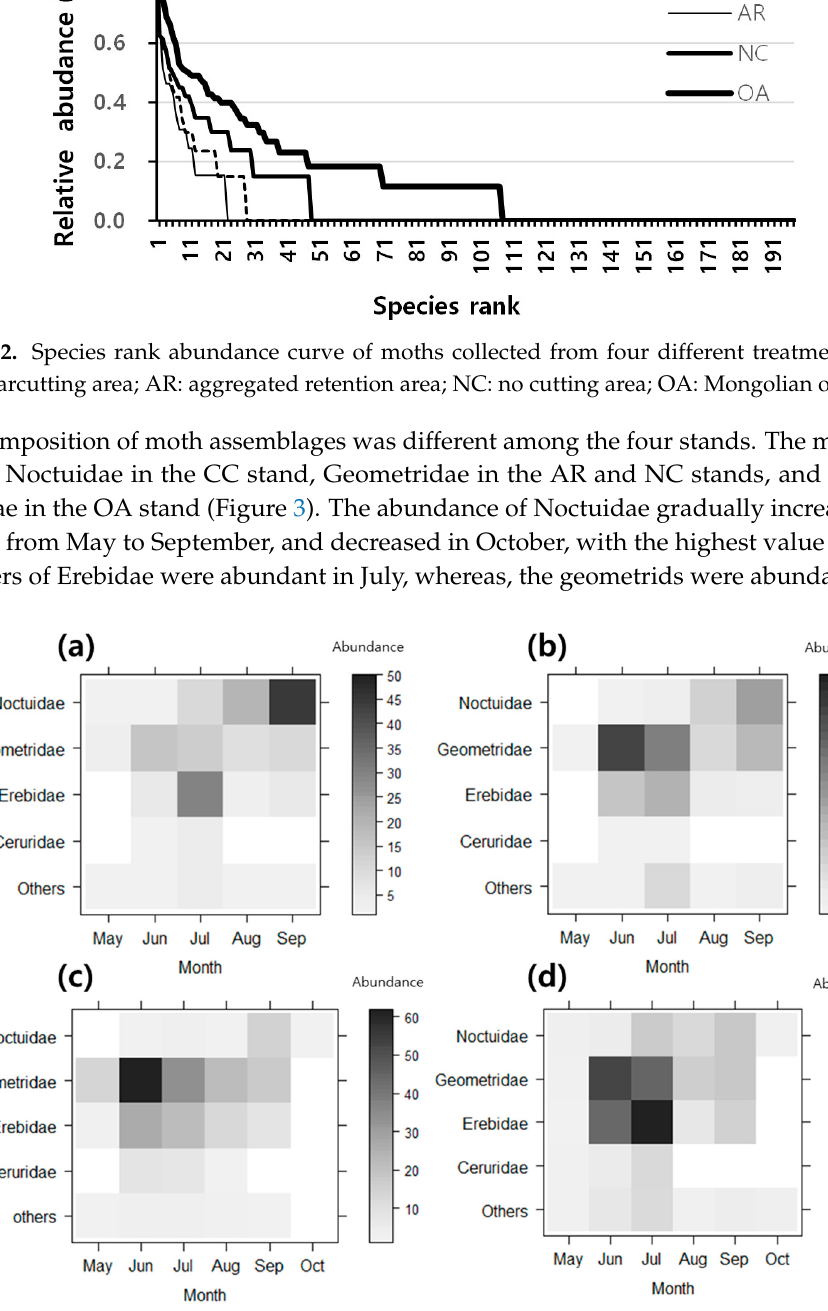
Figure 3. Abundance of the dominant family of species in the four treatment stands at different sampling months. ( a ) Clearcutting area, ( b ) aggregated retention area, ( c ) no cutting area, and ( d ) Mongolian oak area.